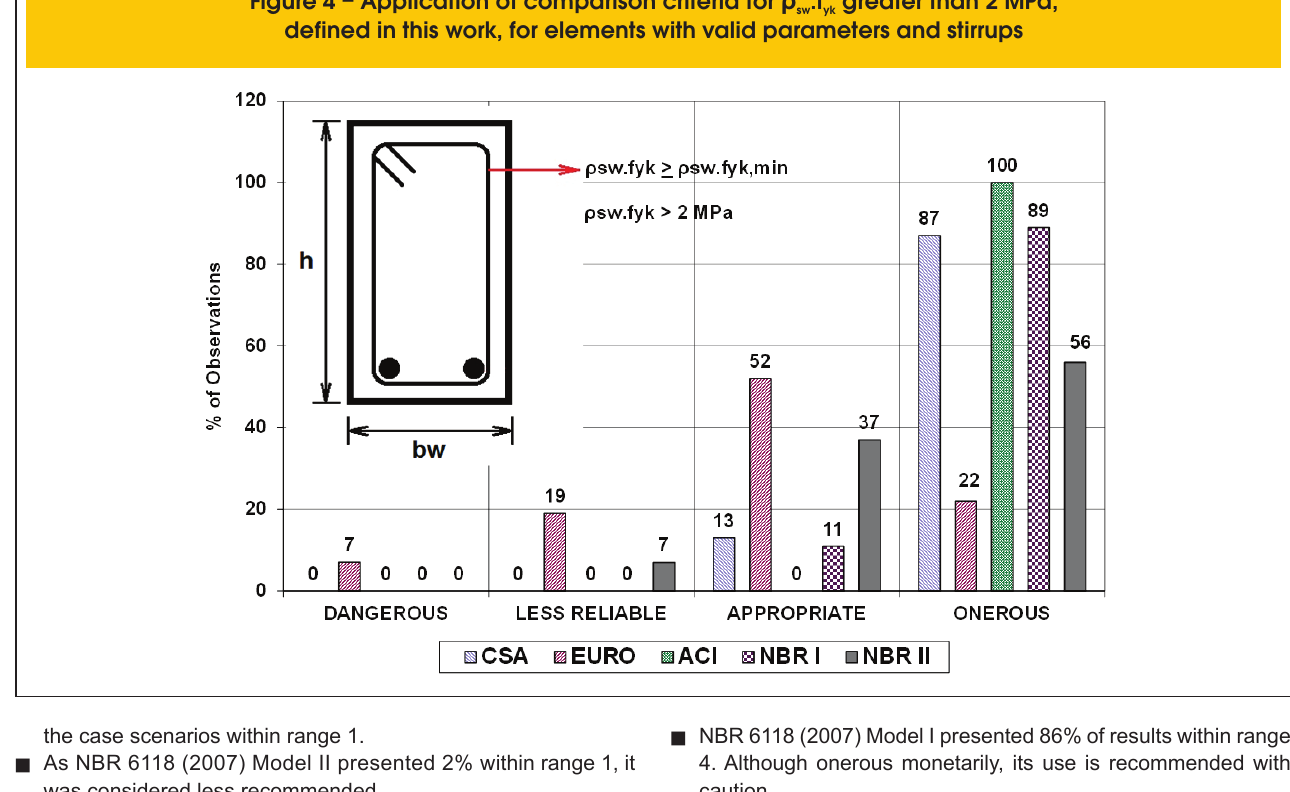
Figure 4 – Application of comparison criteria for ρ .f greater than 2 MPa, sw yk defined in this work, for elements with valid parameters and stirrups